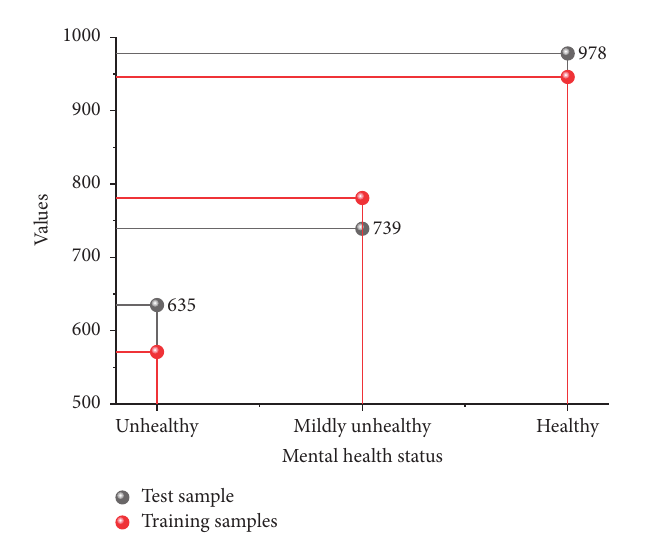
Figure 3: Distribution of training and test sample data. Table 1: Dataset.